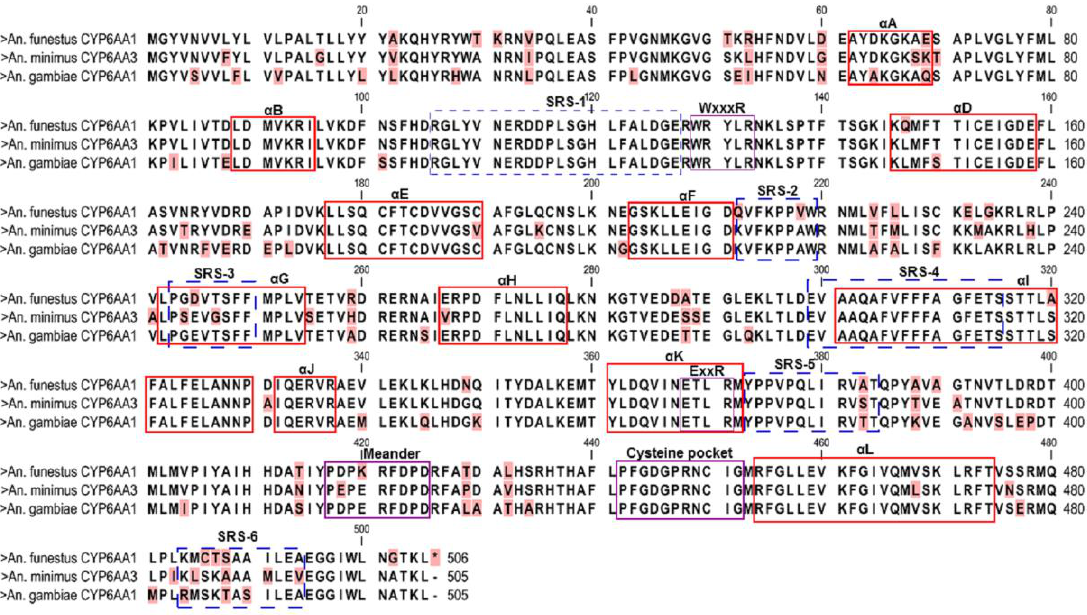
Figure 5. Comparison of A. funestus CYP6AA1 amino acid sequences to A. minimus CYP6AA3 and A. gambiae CYP6AA1. The solid red lines represent helices A-L, while dashed blue lines correspond with the substrate recognition sites 1–6. Solid purple lines identify the structurally conserved motifs of the CYP450s. Variable residues are highlighted in pink. Residues 310–315 corresponds to the oxygen binding pocket.